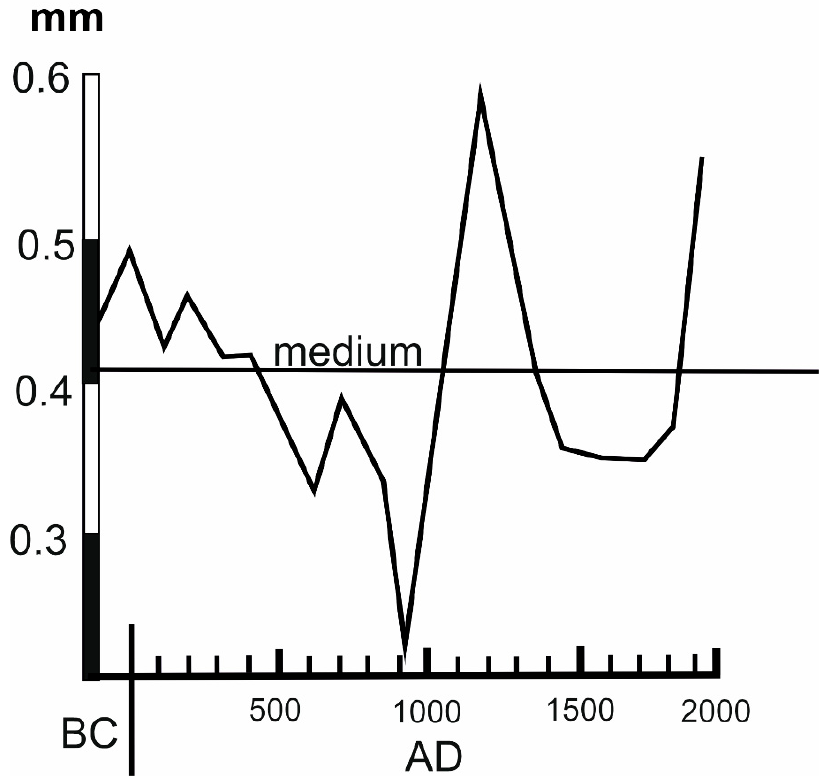
Figure 9. Climatic curve for the last two thousand years based on data on the width of the rings for one of the pine species (in mm); the curve was created based on the data given in [29]. Second only to agriculture in the Late Antique and Medieval periods was distant pastoralism. An important factor for the efficiency of this method was the length of the grazing period in alpine meadows. During the period of the climatic optimum, “the upper boundary of the vertical distribution of forests in the Alps, in the mountains of Central Europe and in Scandinavia increased by 100–200 m” [29]. Thus, it can be presumed that the period of summer vegetation of alpine meadows was longer. However, after the onset of cooling, this pattern changed. An indicative factor in the study of atsanguars (pastoral stock farming areas) is the presence of arrowheads typical for the Middle Ages and the complete absence of any material associated with firearms. Furthermore, the folk epos depicts atsanguars as the houses of Atsan dwarves, and such homes appear in a mythological, fairy-tale context; this suggests that the true purpose of these structures and their role in the economy of the region have been wiped from people’s memories in recent centuries. Climatic variability was also described in greater detail in the medieval epos. As mentioned above, the Nart epos actively reflects severe cooling as a climatic cataclysm